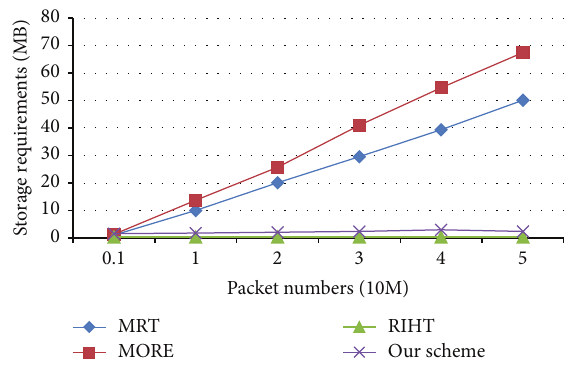
Figure 8: Comparison of storage requirements.